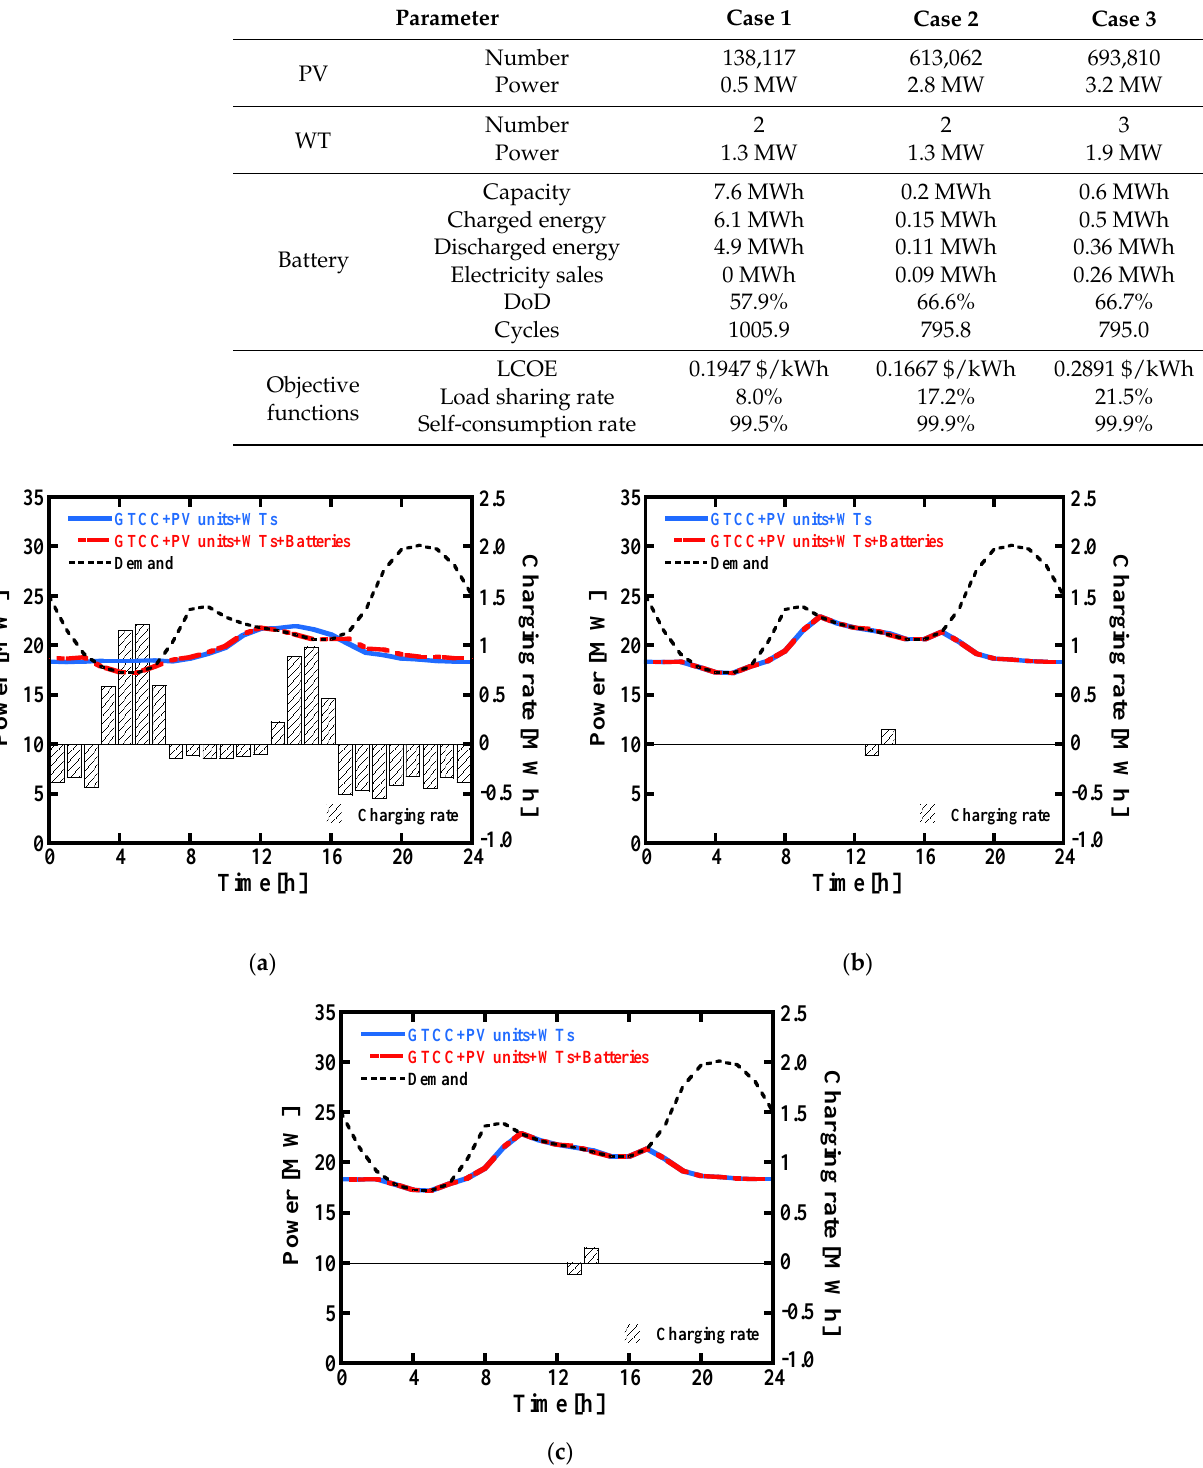
Table 10. Results of the genetic algorithm according to the gas turbine operation mode.